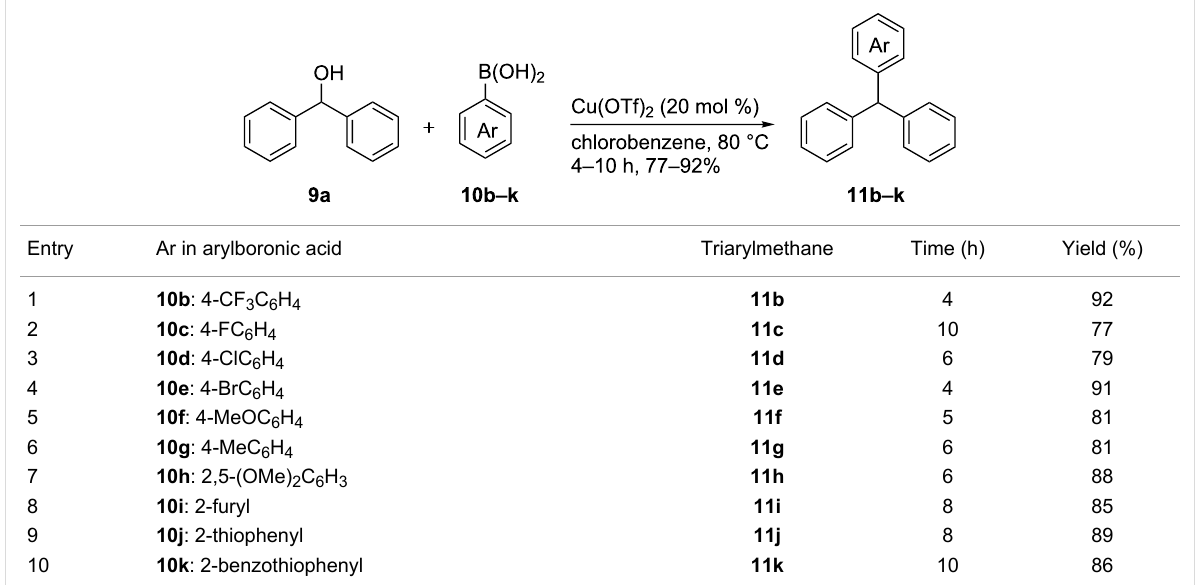
Table 2: Scope of the Cu-catalyzed arylation with various arylboronic acids.